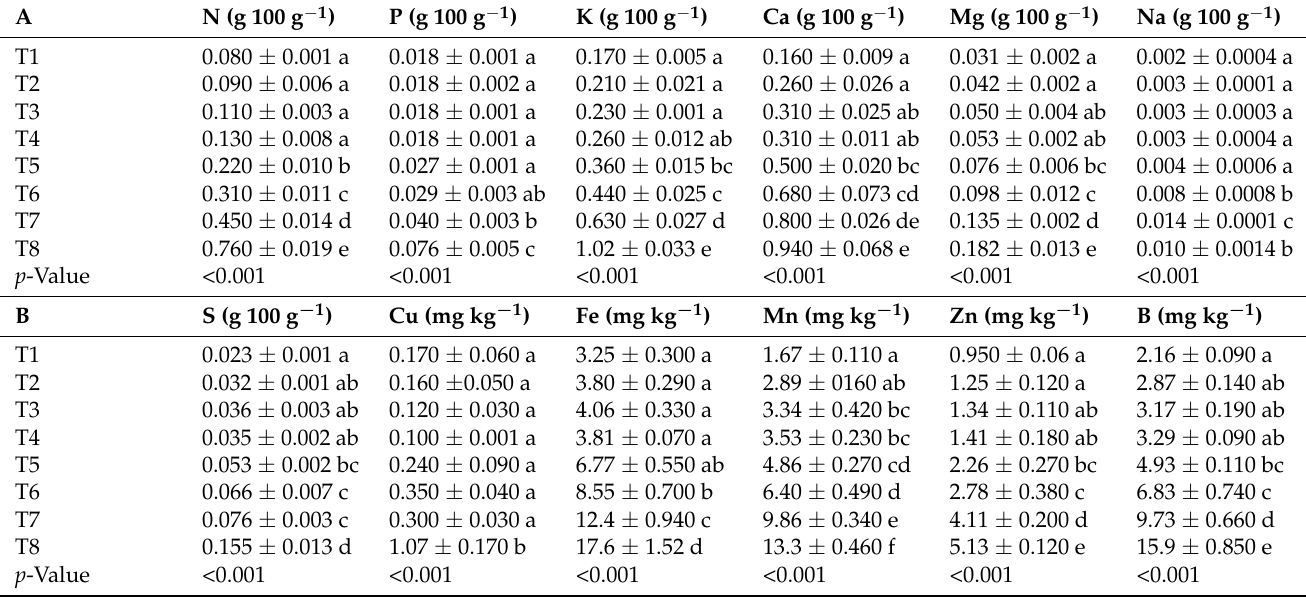
Table 3. Nutrient concentration in vegetative parts (combined shoot and leaf) of tomato plant in greenhouse pot trial with UWP